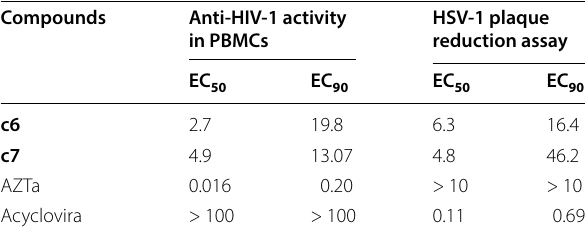
Table 31 Antiviral activity results (µM) of compounds c6 and c7